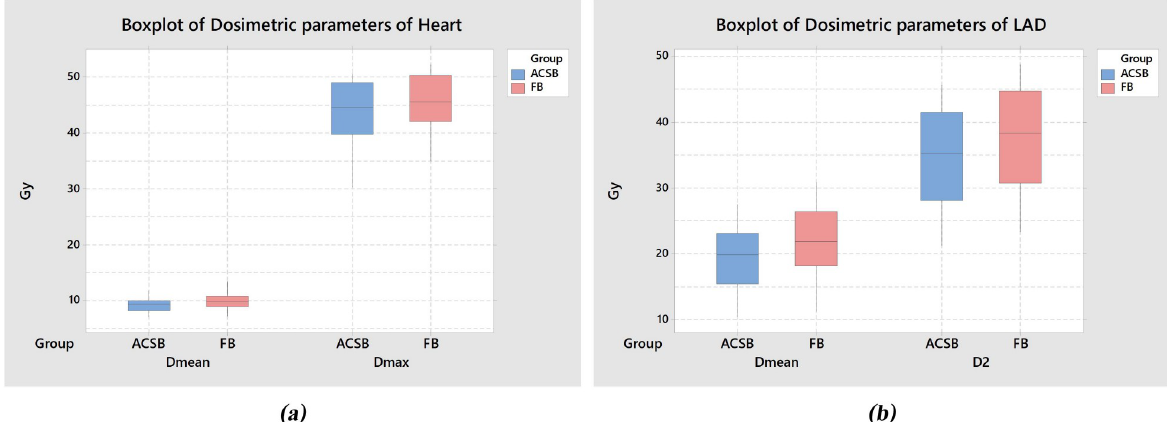
Fig 4. Boxplots of Dosimetric Parameters of Heart (a) and LAD (b) of 20 Patients.